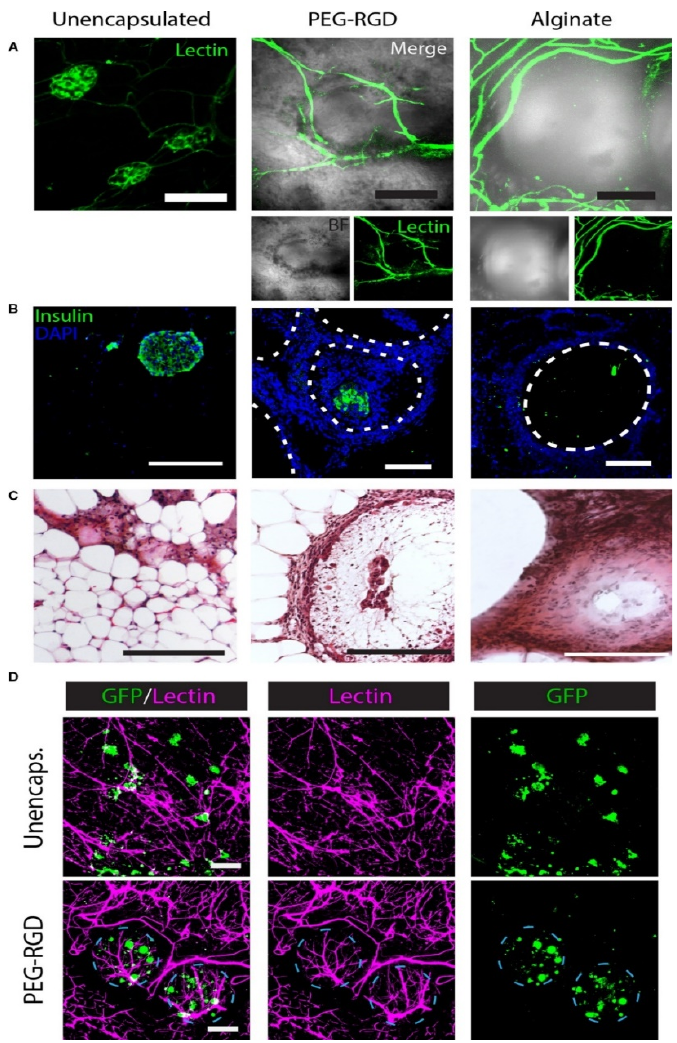
Figure 3. Histological evaluation of EFP-transplanted unencapsulated and encapsulated islets. ( A ) Lectin staining shows the vascular system of the graft; ( B ) IHC staining of the samples; ( C ) H&E staining of the samples; ( D ) Imaging of the PEG-RGD-encapsulated islets shows dense blood vessel formation on the surface of the microgels and living islets within the microgels. Reprinted with permission from Ref. [37] Copyright 2019, John Wiley and Sons.